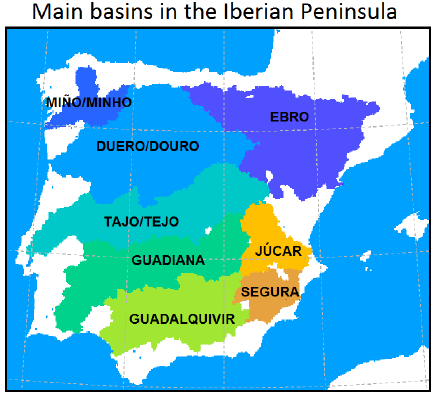
Figure 13. Main river basins in the Iberian